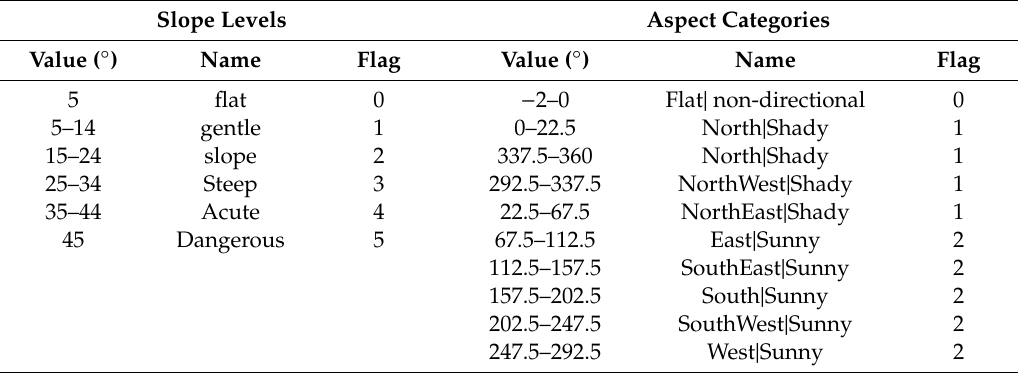
Figure 3. General methodology workflow used for regional volume estimation based on Random Forest (RF) and K-Nearest Neighbor (KNN) model. (The main four steps are highlighted and numbered). Table 3. Slope and Aspect reclassification